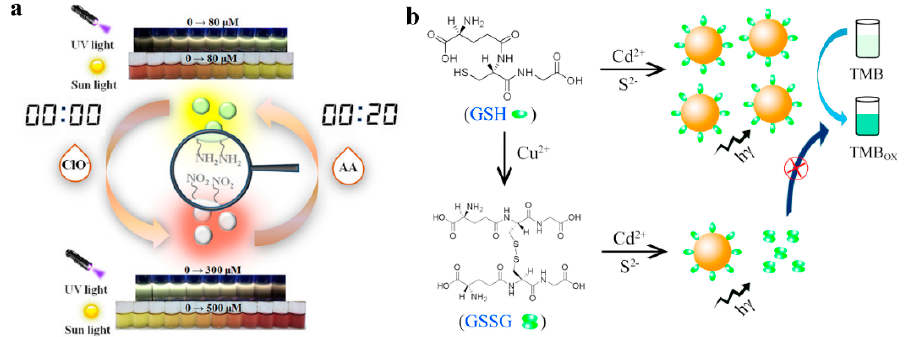
Figure 8. ( a ) The reversible sensing performance of CDs for ClO − and AA in colorimetric and fluorescent mode. Reprinted with permission from Ref. [110]. Copyright 2019 ACS; ( b ) colorimetric sensor for Cu 2+ based on the formation of quantum dots with photocatalytic activity. Reprinted with permission from Ref. [112]. Copyright 2017 Elsevier.